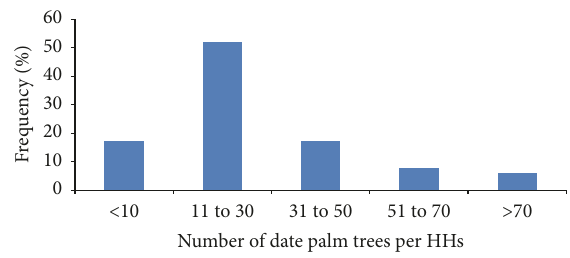
Figure 4: Number of date palm trees owned by the respondent households in the study area. HHs: household